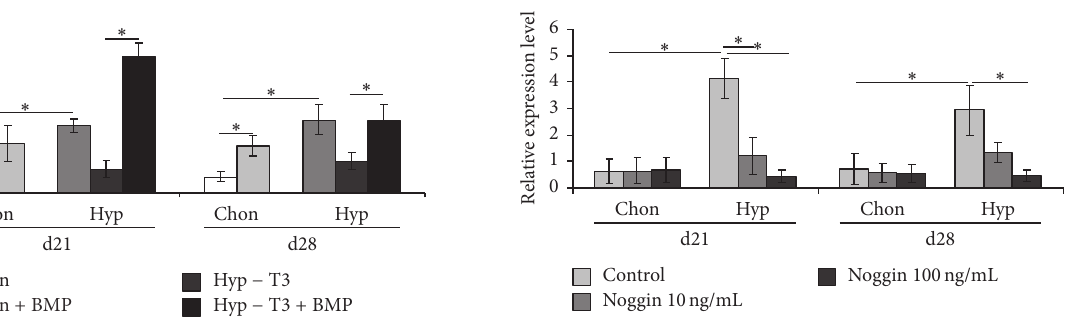
Figure 7: Gene expression analysis of BAMBI normalized to HPRT in MSC pellet cultures after Noggin treatment under chondrogenic (chon) and hypertrophy (hyp) enhancing conditions analysed by real-time PCR. Noggin treatment significantly decreases BAMBI expression under hypertrophic conditions. 𝑛 = 4 different donors, ∗ 𝑝 < 0.05